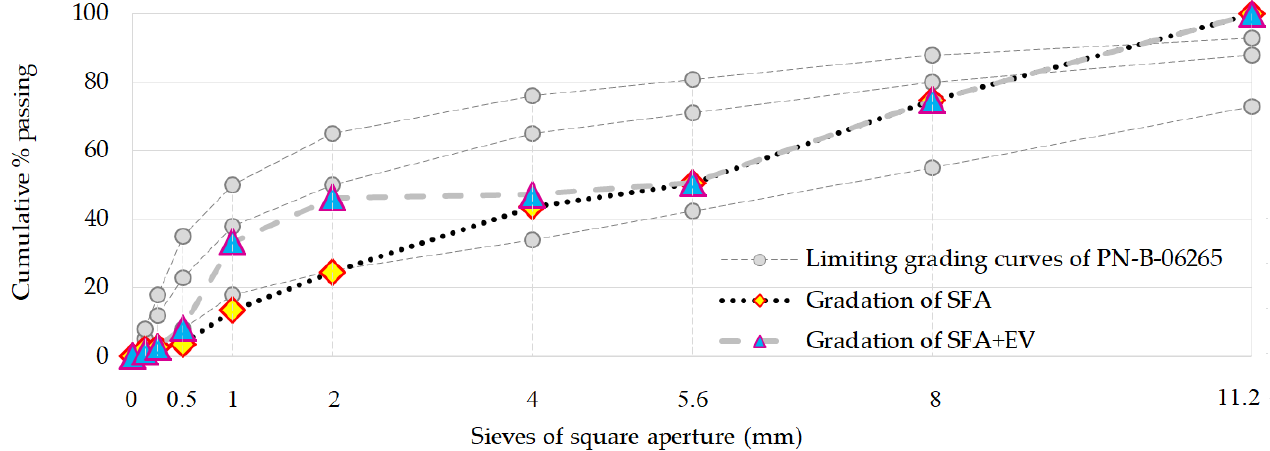
Figure 4. Grading curves of SFA and SFA + EV aggregate mixes.